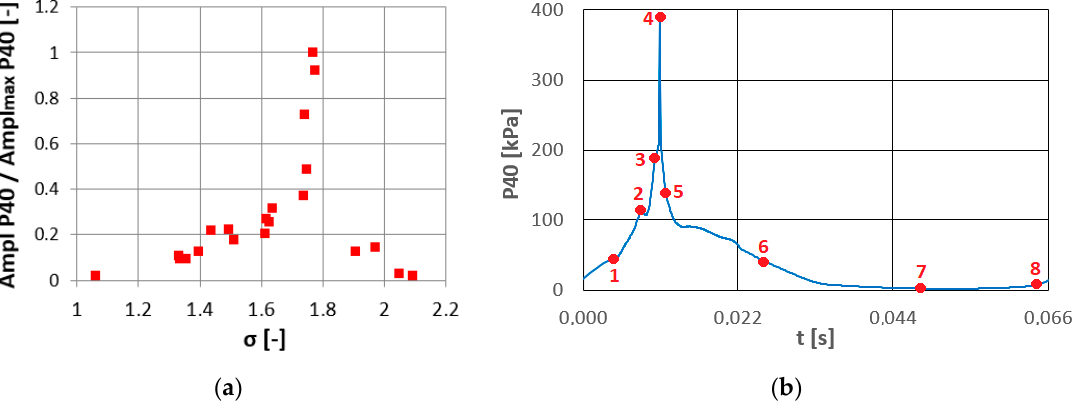
Figure 19. ( a ) Normalized amplitudes of pressure pulses measured at midspan of hydrofoil at 40% chord length; ( b ) pressure pulse calculated during one typical shedding cycle and scheme of control points.